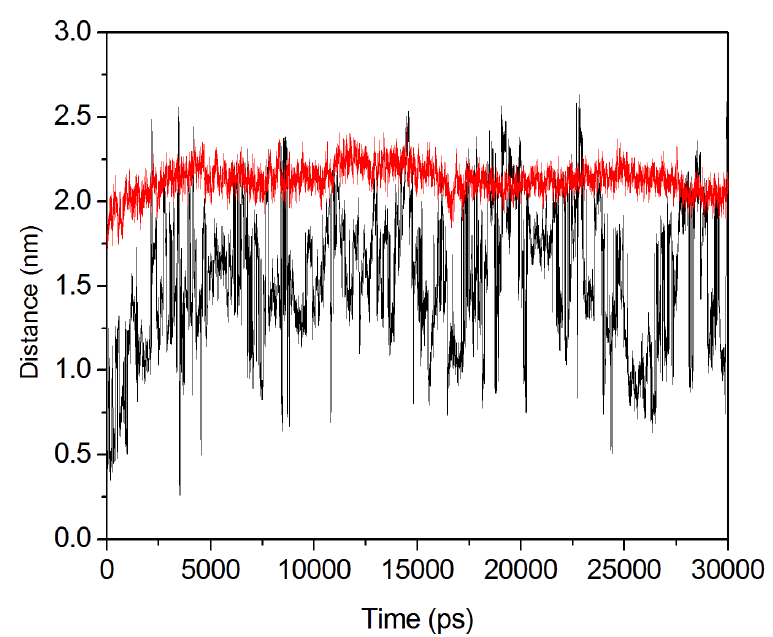
Figure 11. The distance between the C α of L271 and F132 in the WT enzyme (black). The distance between the C α of E263 and F132 in the loop 7-2/H254R